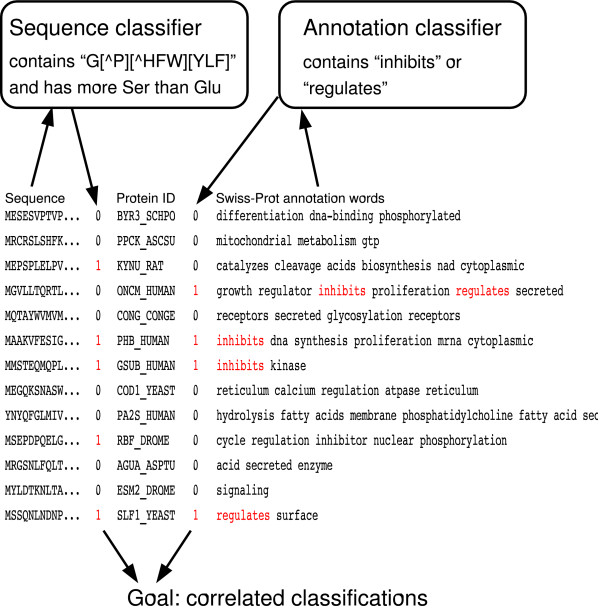
Outline of approach: simultaneous sequence and annotation classifications. Part of the dataset is shown with sequences (to the left) and Swiss-Prot annotation words (to the right). The evolutionary search produces two independent classifiers which act on the two types of information. Fictional examples of these classifiers are shown. Two binary vectors are produced from the application of these classifiers to their respective inputs. Ideally, a pair of classifiers would produce identical (non-trivial) binary vectors. The goal of the evolutionary search is to maximise the correlation between these vectors.